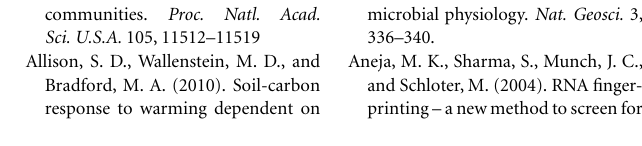
of C. In mineral soil (outlined in brown), microbial community composition likely only controls the fate of C. In dead roots, community composition probably regulates both rate and fate, but little research has been done on this